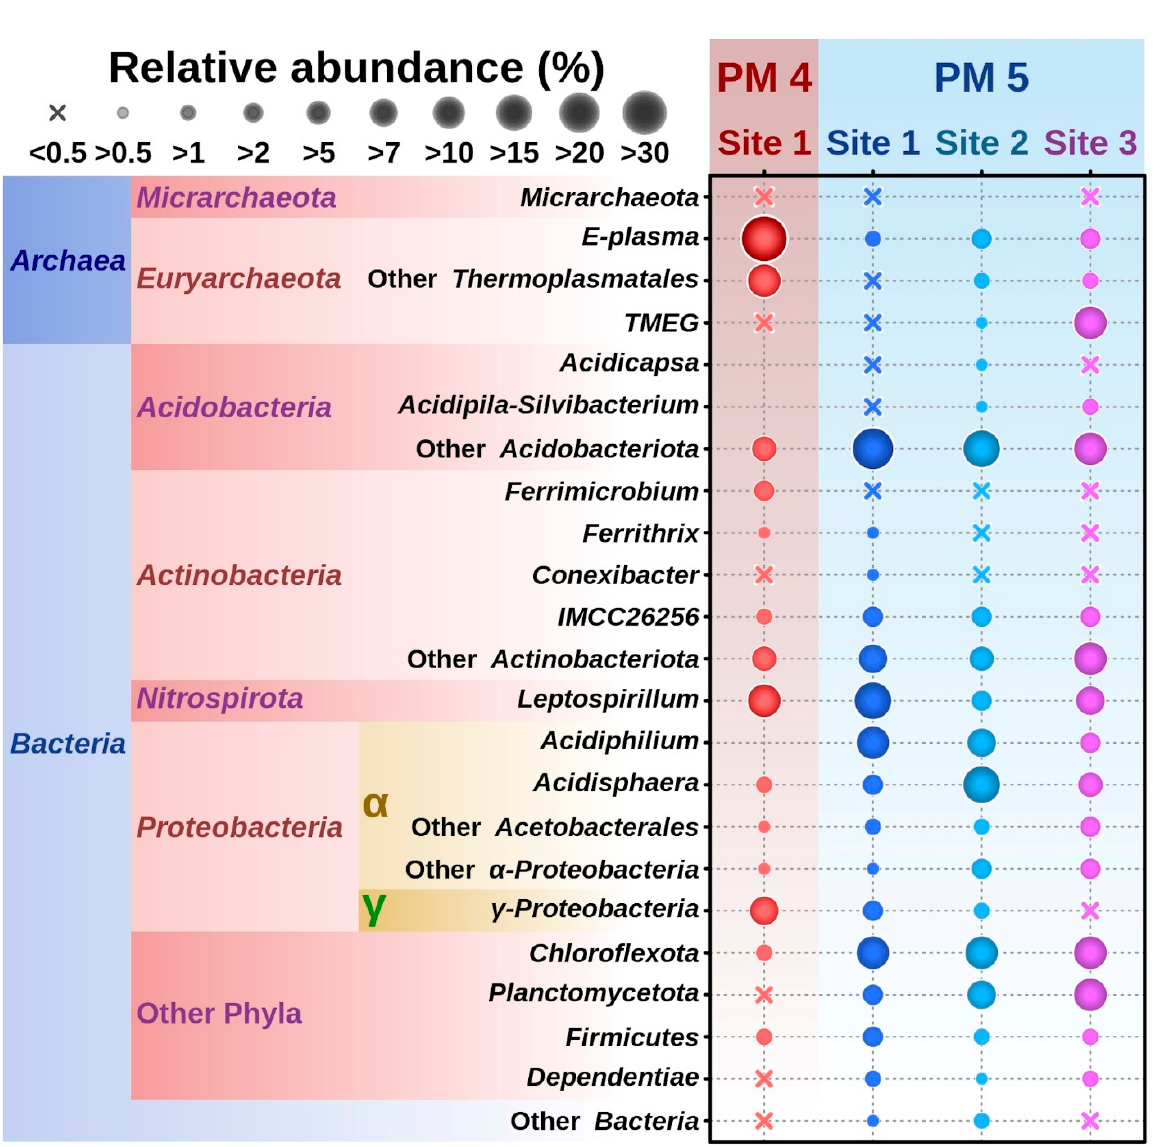
Figure 4. Relative abundances of 16S rRNA gene amplicon reads of the prokaryotic most represented taxonomic groups (MATGs) across the three localities of the PM5 site (PM5.1, PM5.2 and PM5.3) and PM4 site, Parys Mt. Circles represent the average relative abundance (%), n = 3. MATGs were selected according to a > 2% cut off, except for Ca . Micrarchaeota.